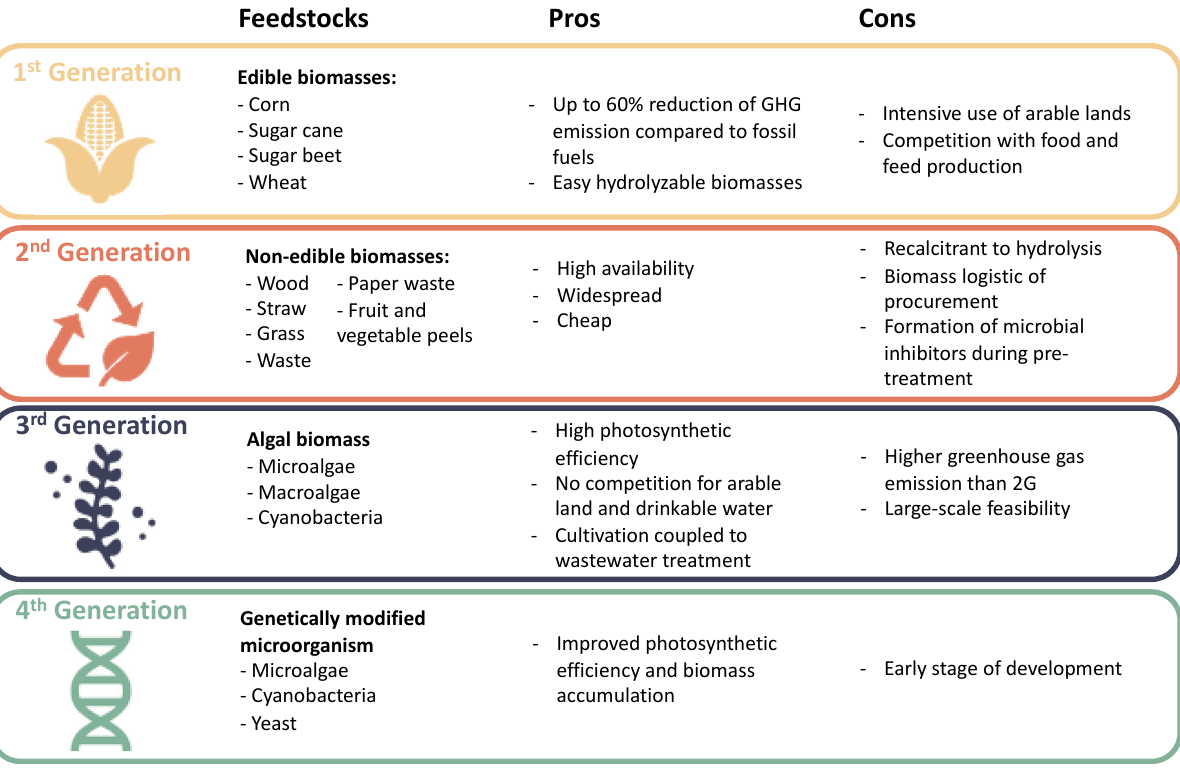
Figure 1. The four bioethanol generations.